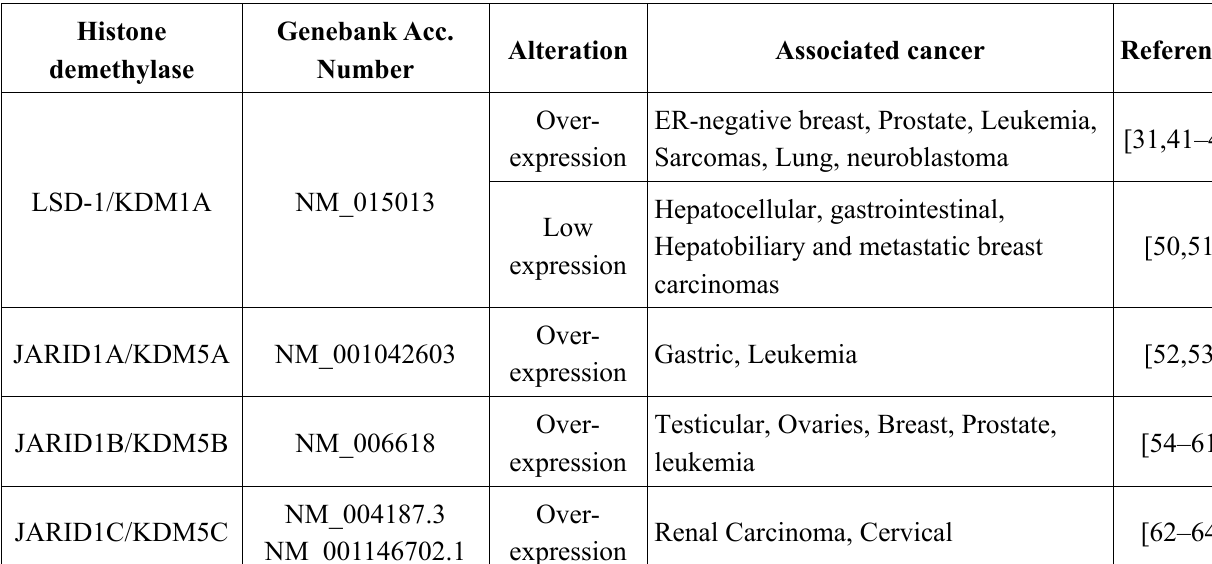
Table 1. Histone demethylases and their association with cancer